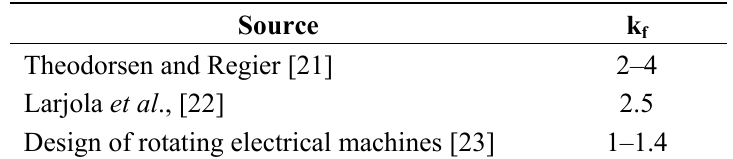
Table 4. Values of k , measured empirically and reported in f